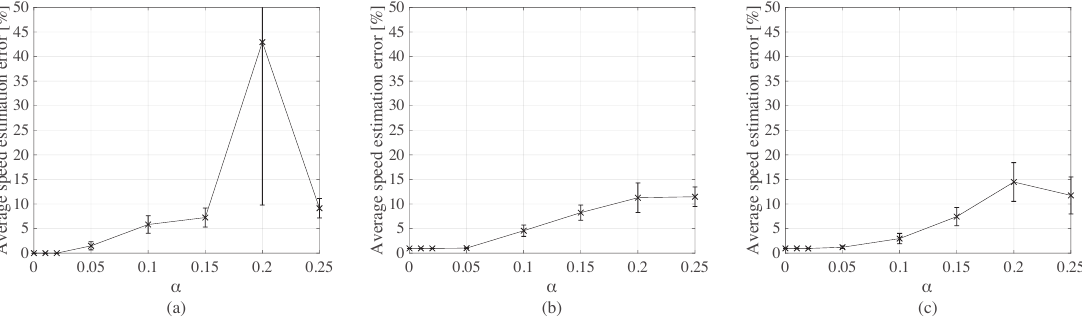
Figure 11. Mean speed estimation error (with +/- standard deviation intervals) as functions of noise level for: ( a ) type 1 truck; ( b ) type 2 truck; and ( c ) type 3